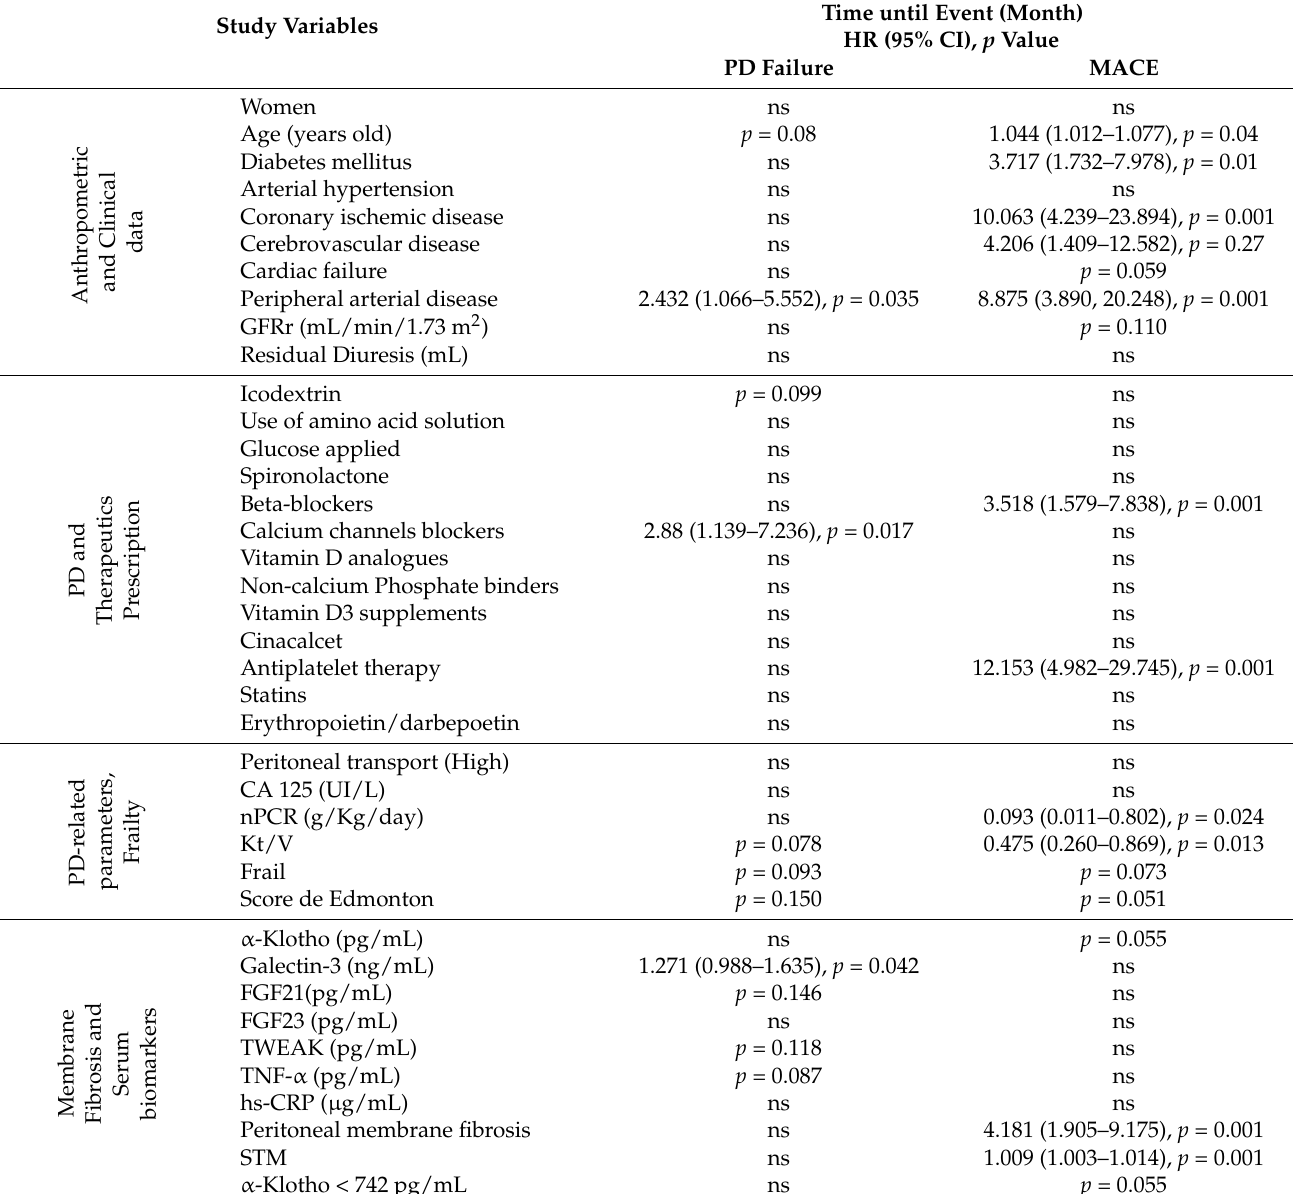
Table 3. Baseline variables as predictors of 5-year peritoneal dialysis